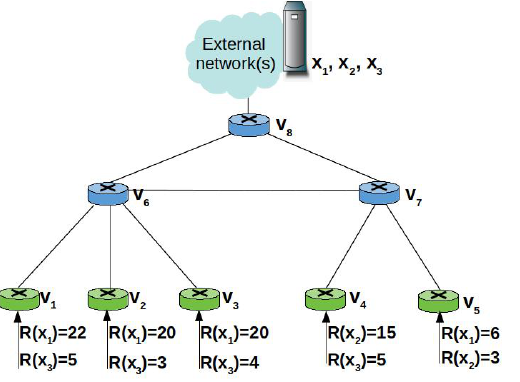
Figure 6. Toy example: an edge network with eight